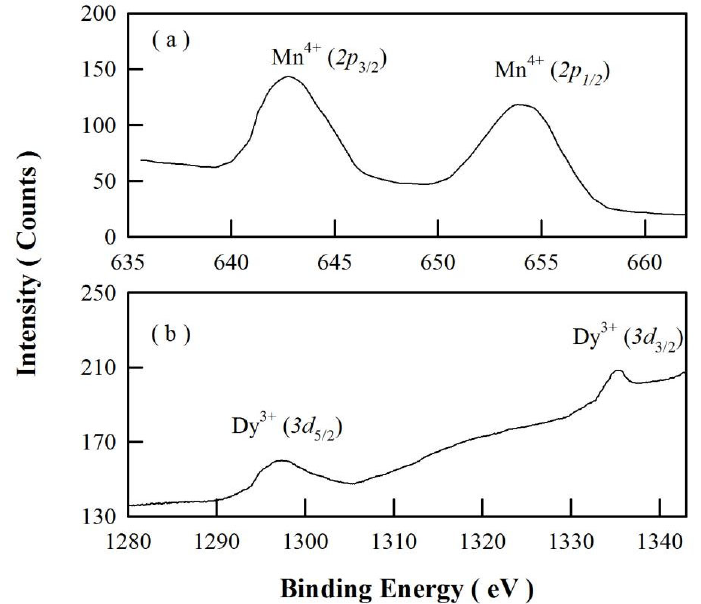
Figure 4. High-resolution XPS spectra of Mn 2p ( a ) and Dy 3d ( b ) in SrAl 2 O 4 :Dy 3+ after Mn 4+ diffusion at 900 °C for 4 h.